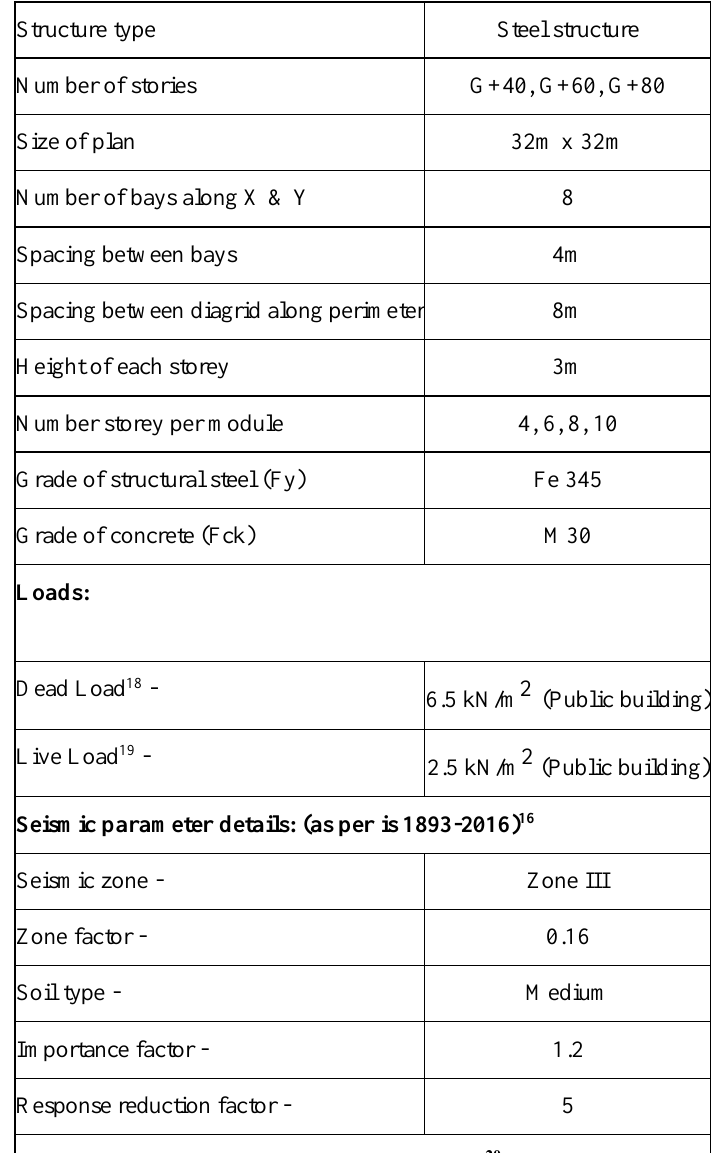
Table 1 Geometric parameters of the building